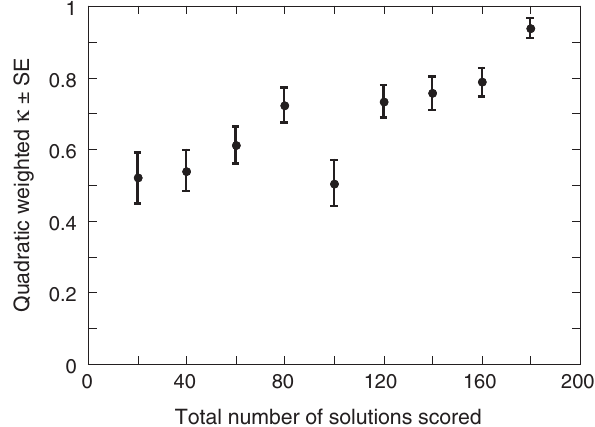
FIG. 7. Graph of score agreement (weighted kappa) for two raters as a function of number of solutions scored for eight problems. The solutions were scored sequentially in time. The ninth data point is a rescoring of the first problem initially scored as the first data point.